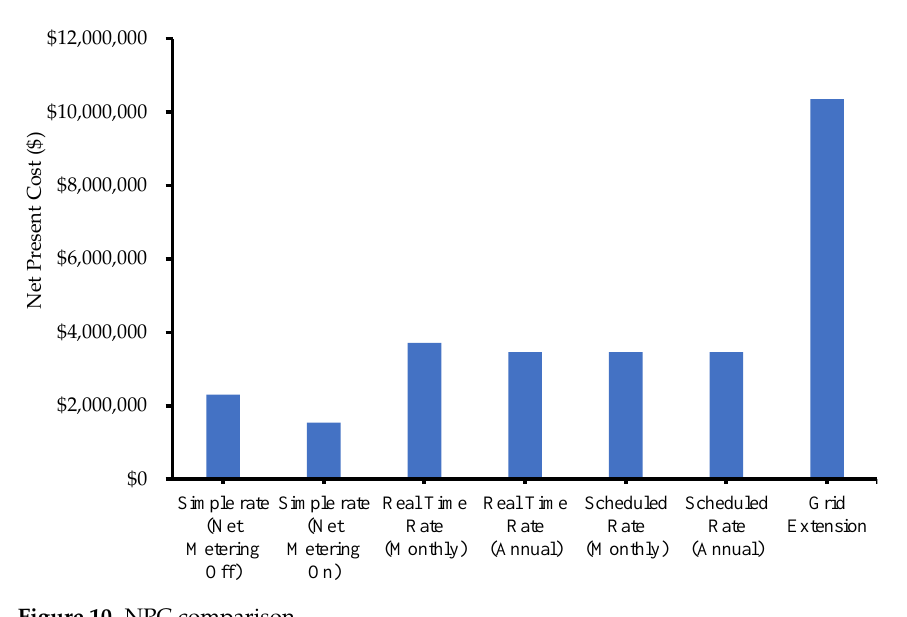
Figure 10. NPC comparison.